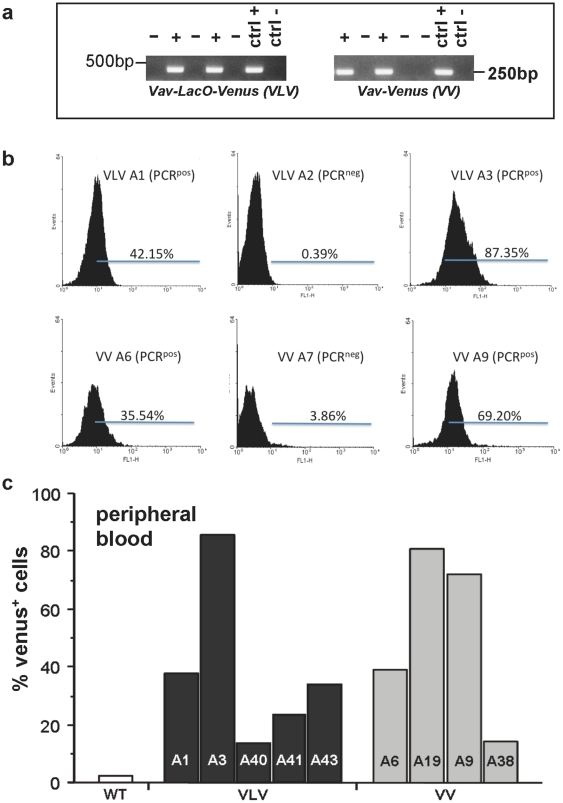
Identification of transgenic mice.The VavLacOVenus (VLV) plasmid as well as an unmodified version of the VavP plasmid encoding Venus cDNA (VV) were digested with AseI and PvuI and an approximately 9.2 kb AseI-PvuI fragment was used for microinjection into fertilized FVB oocytes. (a) Transgenic founders were first identified by PCR genotyping on tail DNA. VLV  =  VavLacOVenus transgenic mouse, VV  =  VavVenus transgenic mouse, WT  =  wild type FVB mouse. (b) Histograms from flow cytometric analysis showing different levels of transgene expression in PCR-typed founders. (c) Range of transgene expression levels in PCR+ founders, quantified as in (b).